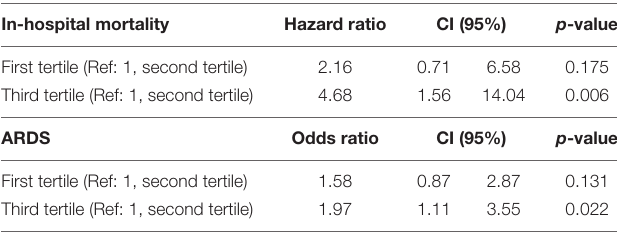
TABLE 2 | Adjusted models for in-hospital mortality and ARDS risk according to the CD4/CD8 T-cell ratio tertiles. In-hospital mortality Hazard ratio CI (95%) p -value